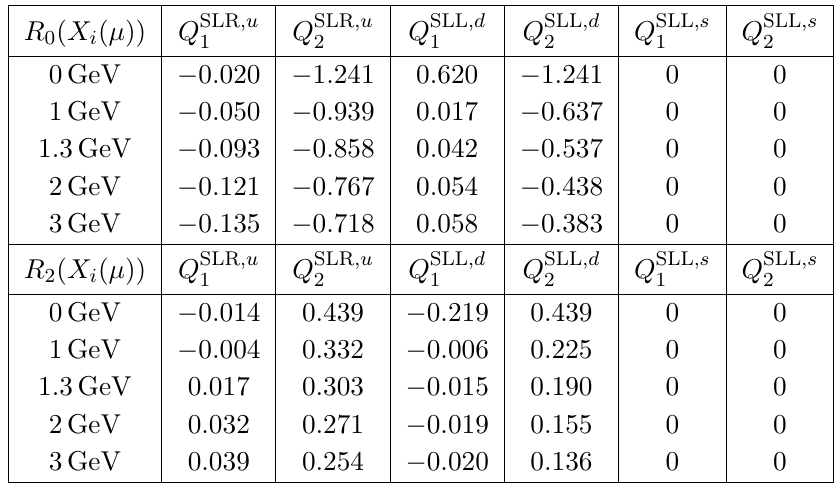
Table 9 . Ratios R I of BSM operators in the SD basis allowed by SU(3) SMEFT over ^ Q 8 contributing to the isospin amplitudes A 0 ; 2 for four values of (cid:22)